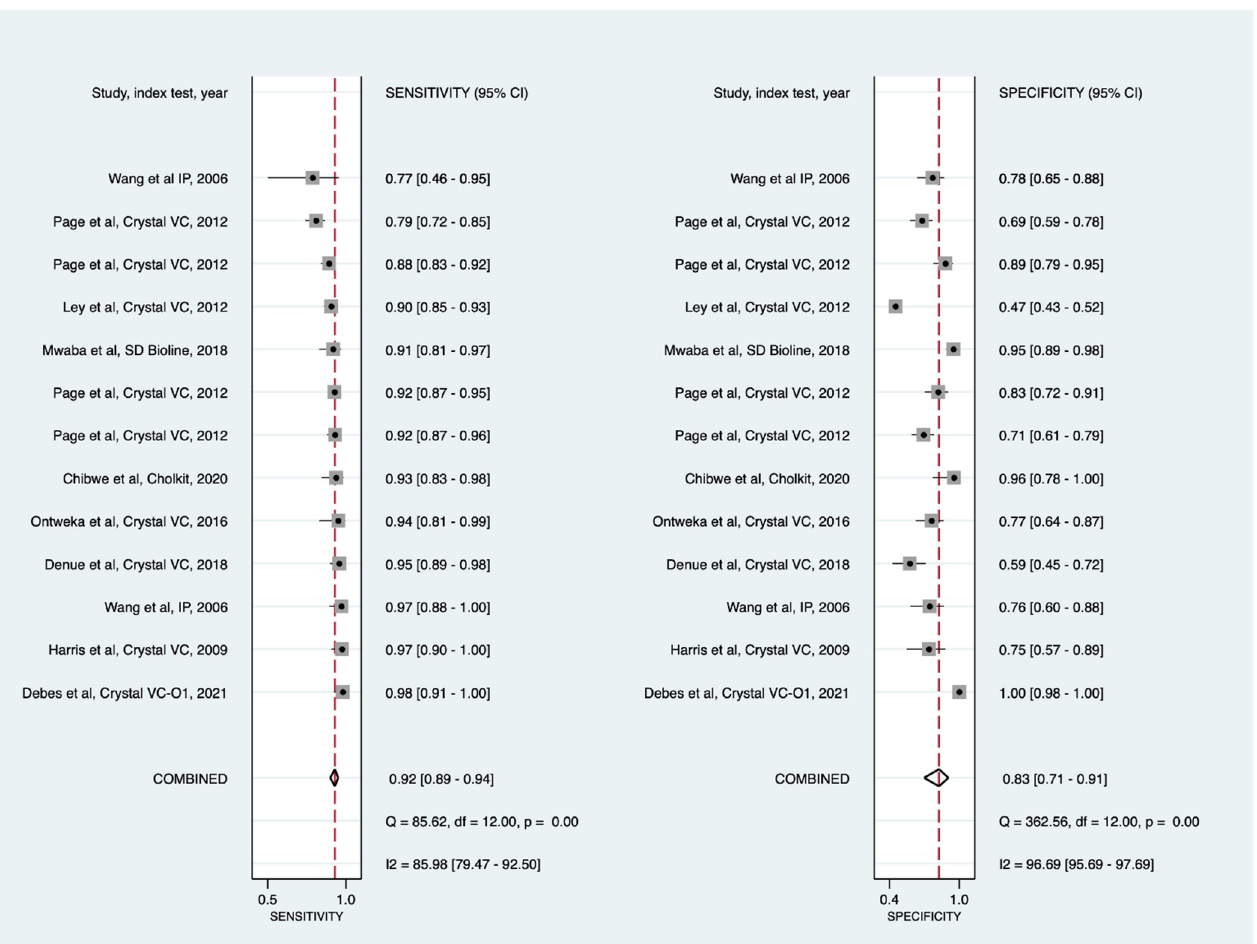
Figure 4. Forest plots of the sensitivities and specificities of cholera rapid diagnostic tests (direct stool testing) with their 95% confidence intervals. This subanalysis was restricted to studies conducted in Africa. CI = confidence interval; IP = Institut Pasteur.